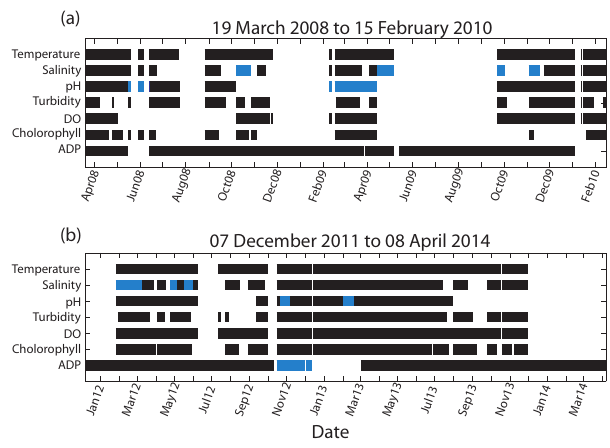
Figure 2. Extent of the valid data (black lines) recorded by the SIM- PATICO monitoring station (a) from 19 March 2008 to 15 February 2010; and, (b) from 7 December 2011 to 8 April 2014. The sta- tion was not operating in between these two periods. The blue lines indicate ambiguous probe data and accepted ADP data.